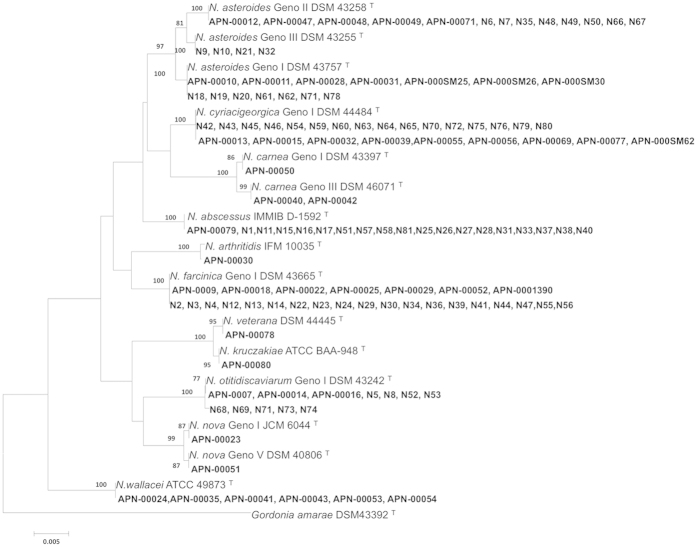
16S rRNA sequence-based phylogenetic tree of clinical isolates of Nocardia with those of closely related species which computed by the NJ analyses and K2P model.The support of each branch, as determined from 1000 bootstrap samples, is indicated by percentages at each node. Bar 0.005 substitutions per nucleotide position.